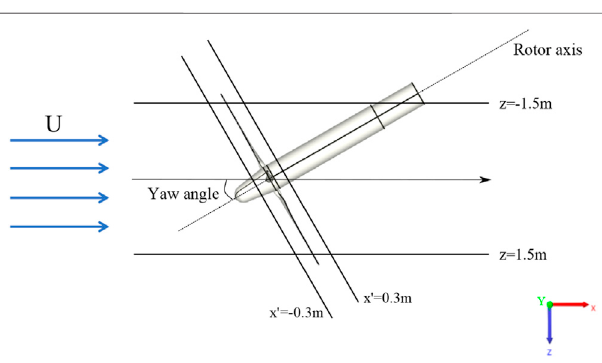
FIGURE 2 | Location of measurement data in the New MEXICO